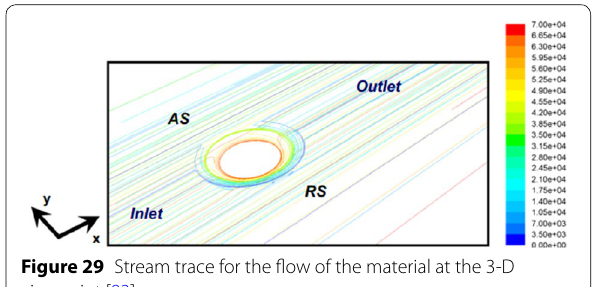
Figure 29 Stream trace for the flow of the material at the 3-D viewpoint